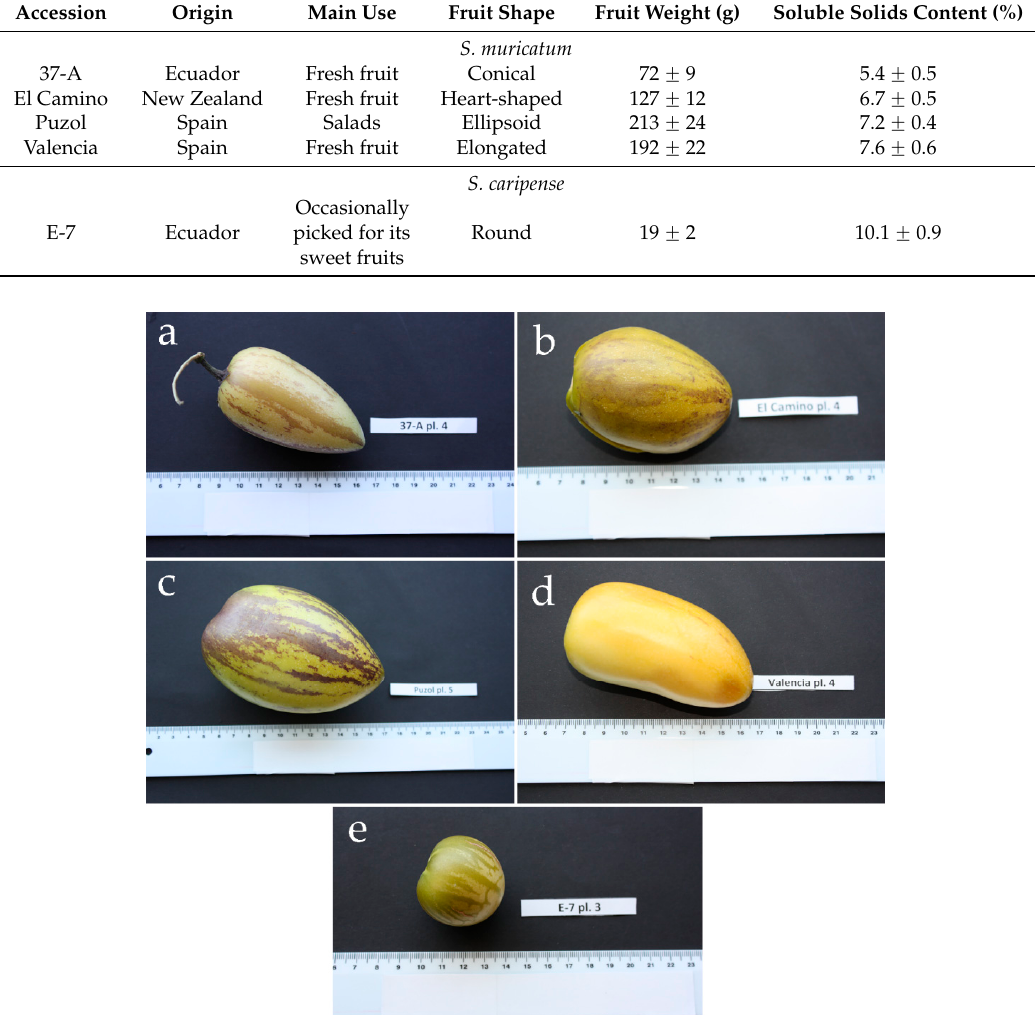
Table 5. Pepino ( S. muricatum ) and its wild relative S. caripense accessions used in the present study and main fruit characteristics.